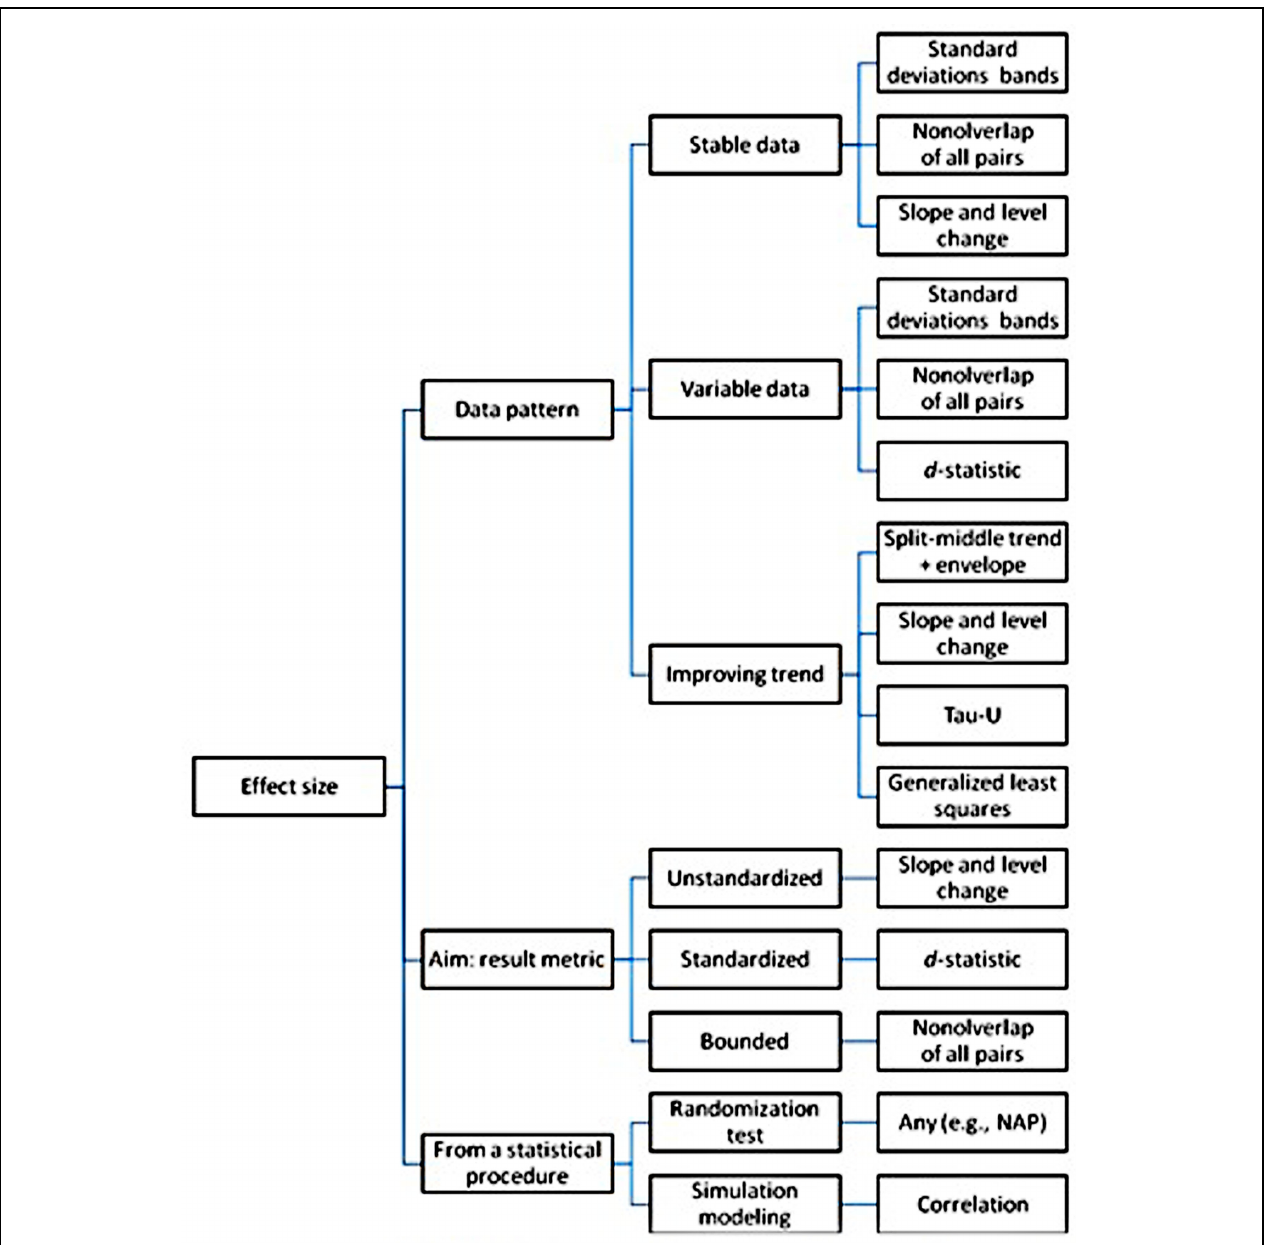
FIGURE 3 | Graphical (simplified) summary of the recommendations regarding the use of several analytical techniques for single-case experimental and pre-experimental